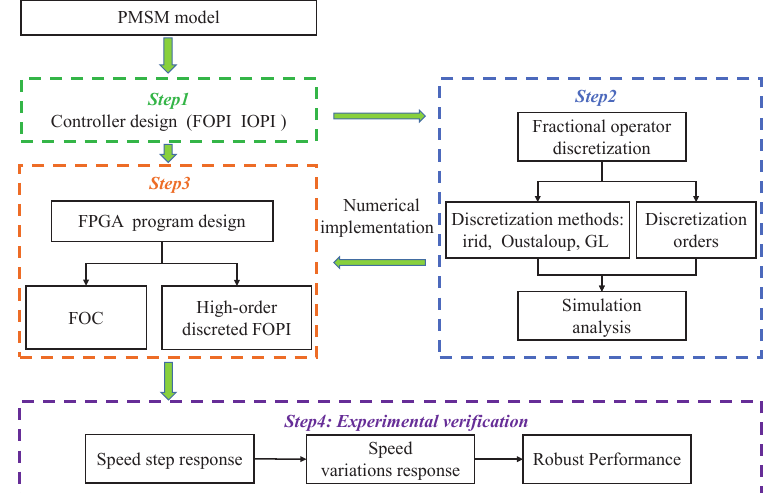
Figure 1. The research workflow of this